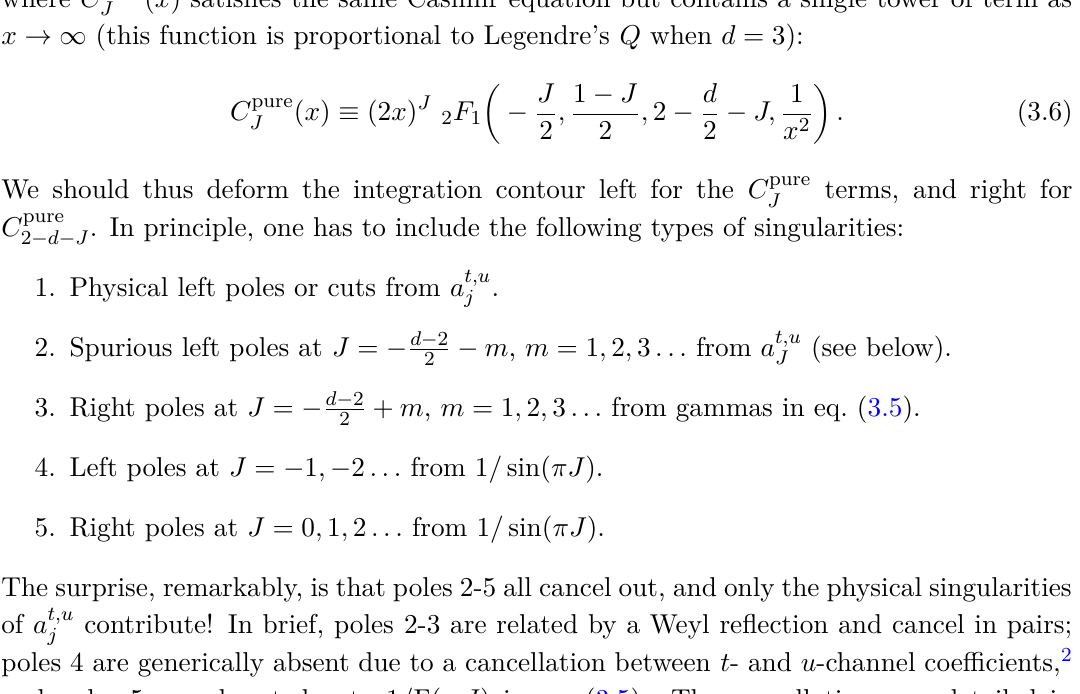
Figure 5 . Spurious poles of type 2 and 3 cancel each other. The physical Regge pole is shaded black. where C pure